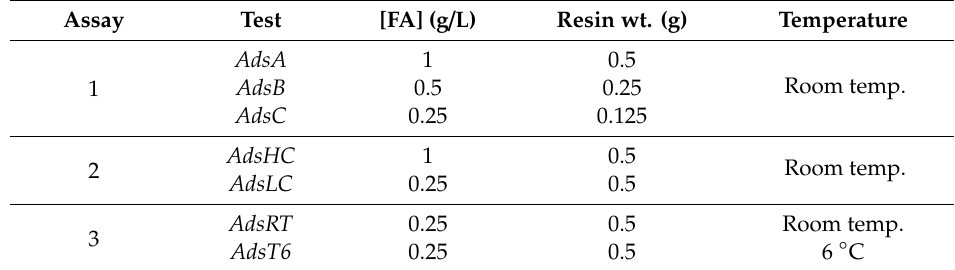
Table 1. Conditions of the adsorption mixtures during in adsorption kinetic studies. The volume of ferulic acid (FA) solution used in each teste was constant (50 mL). Assay Test [FA] (g / L) Resin wt. (g) Temperature AdsA 1 0.5 1